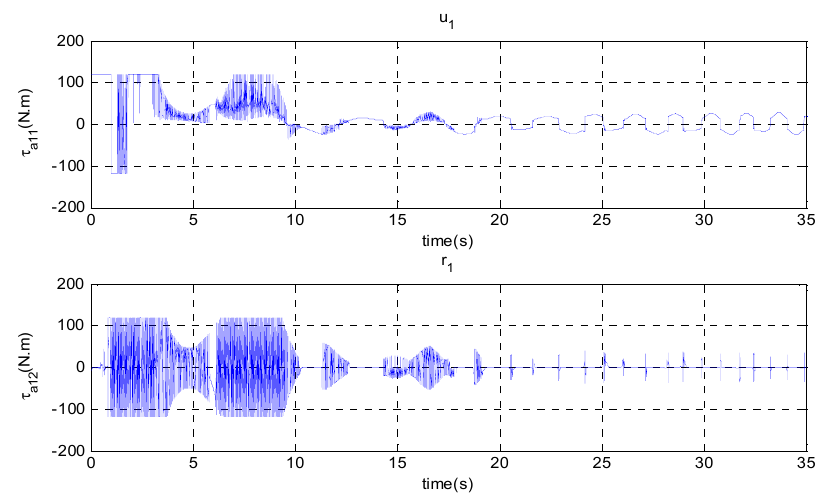
Figure 6. Leader-follower trajectories in Example 1.